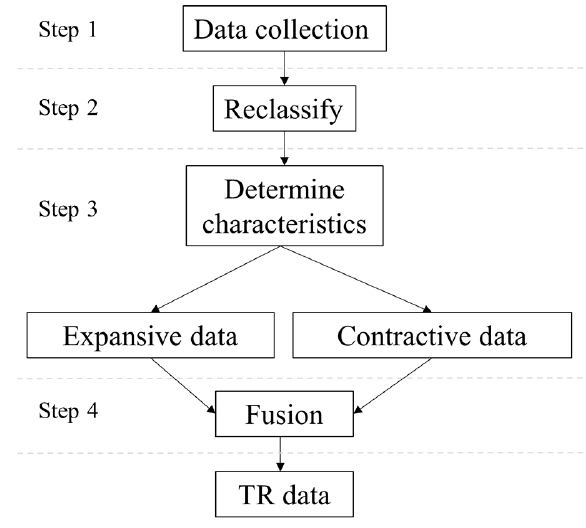
Figure 2. The generation steps of time ring (TR) data.